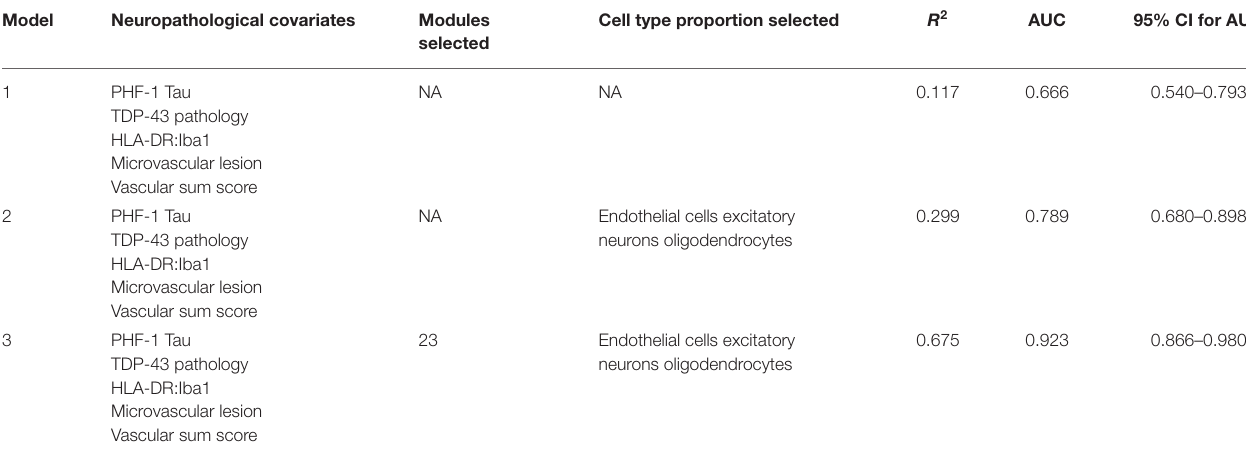
TABLE 3 | Comparison of models of psychosis.